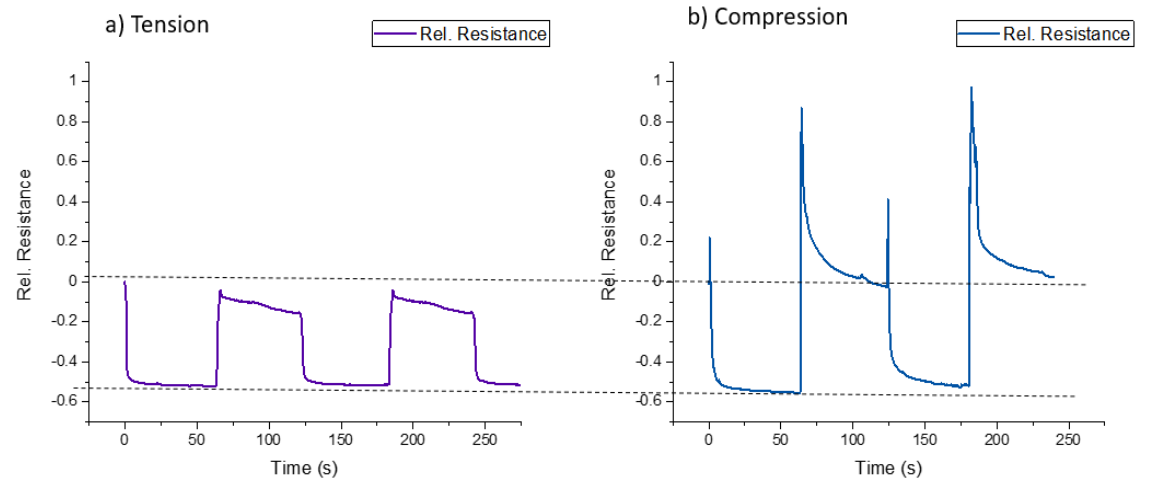
Figure 12. The electrical signal of the piezoresistive skin attached to ( a ) the pneumatic-based actuator and ( b ) the tendon- based actuator during the quasi-static testing, with a dwell time of 60 s at the points of maximum and minimum defor- mation.